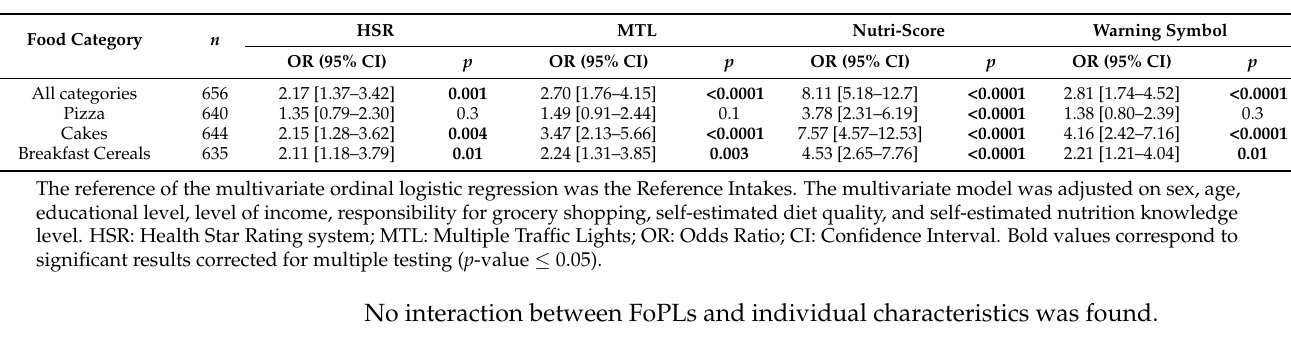
Table 3. Associations between FoPL exposure and ability to rank products among participants recalling seeing the label.